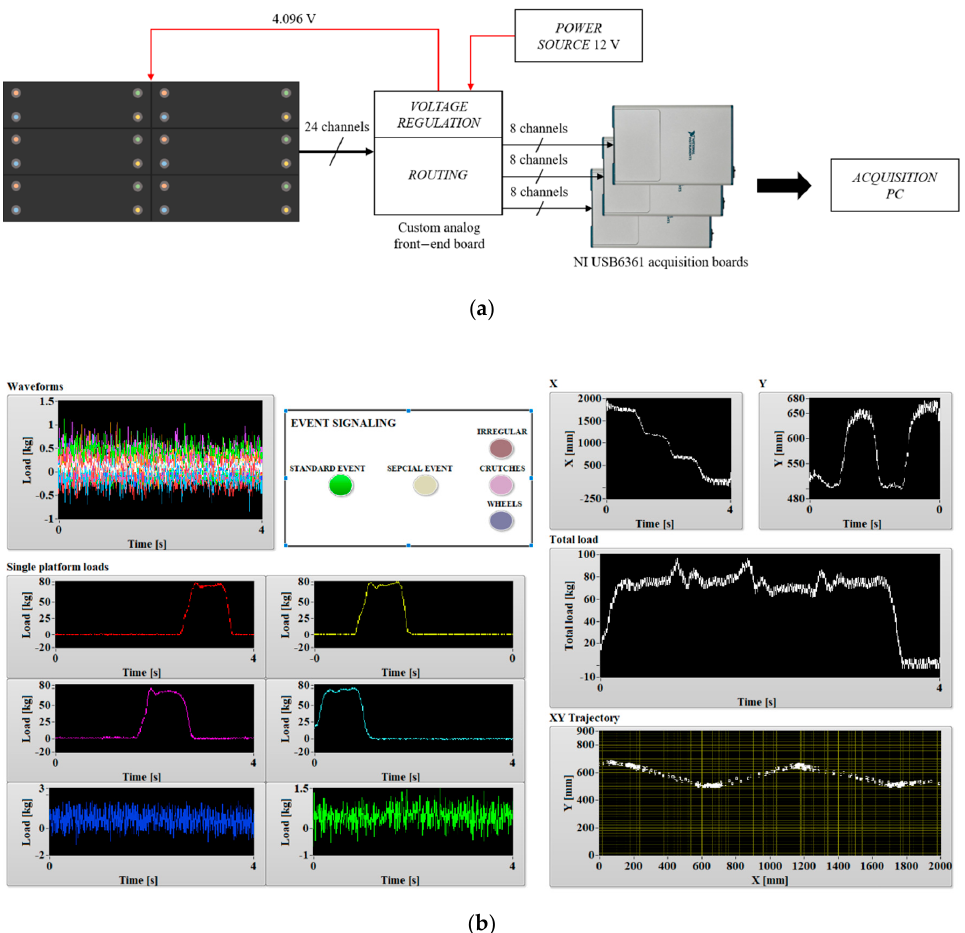
Figure 5. ( a ) Acquisition system block scheme. ( b ) Detail of the front panel of the LabView VI managing the acquisition and implementing the data processing.